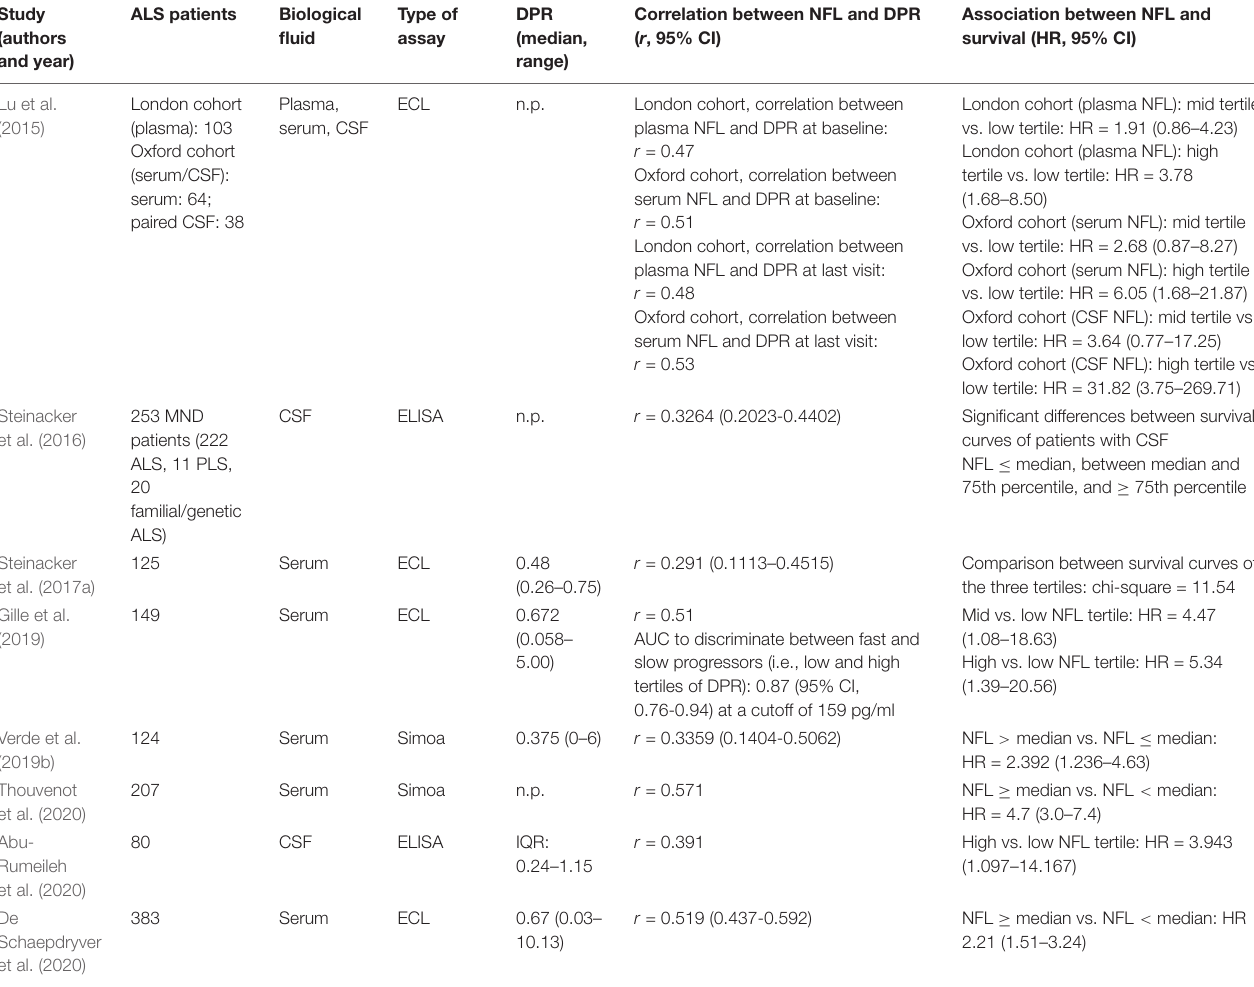
TABLE 2 | Representative studies on the association of NFL with progression rate and survival in ALS. Study (authors